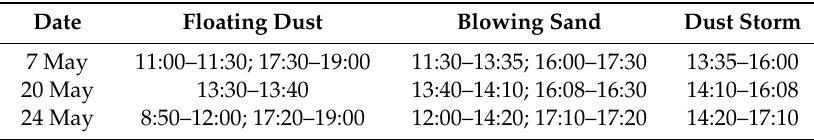
Table 2. Observation times of the dust storm processes.